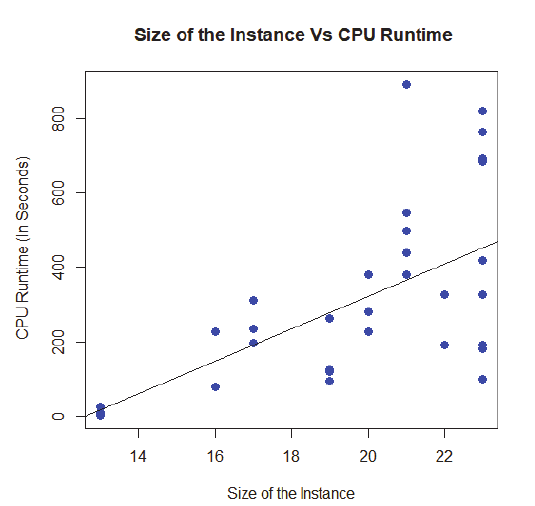
Fig. 7. Scatter plot with correlation +0.6009